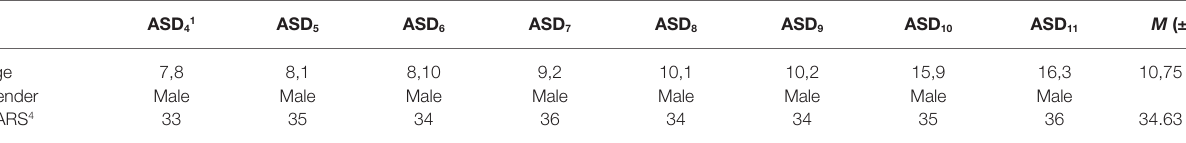
TABLE 3 | The participants’ details (Study 2).